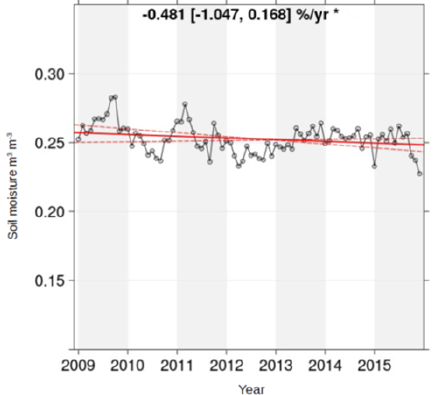
Figure 4. Brazilian soil moisture trend from 2009 to 2015.